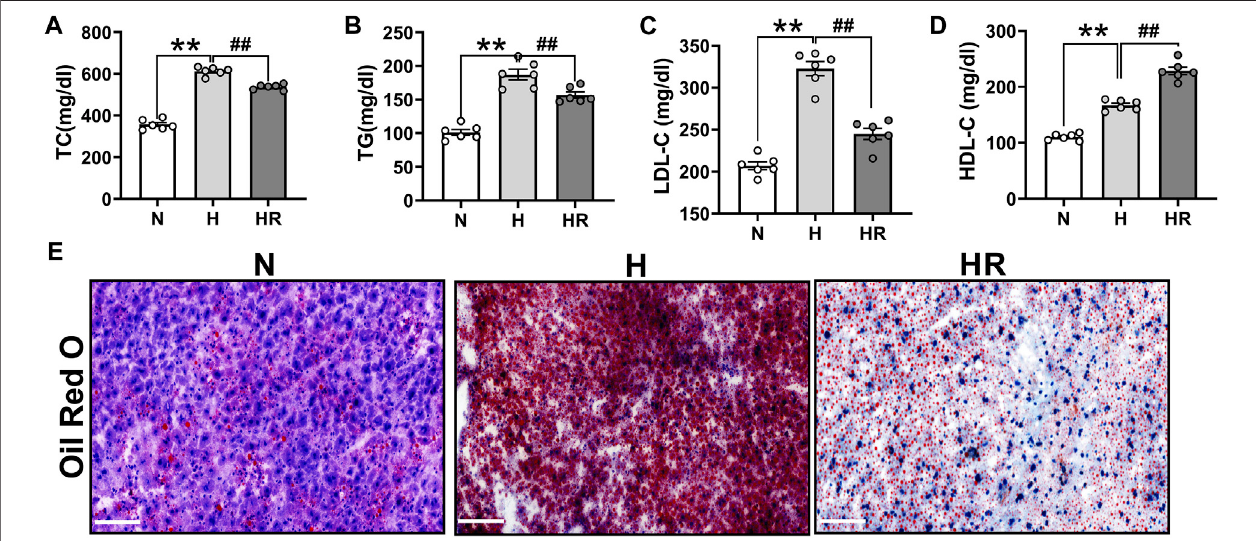
FIGURE 2 | Resveratrol regulated serum lipid and prevented the lipid accumulation in the liver of ApoE − / − mice. (A – C) Total cholesterol (TC) (A) , triglycerides (TG) (B) , and low-density lipoprotein cholesterol (LDL-C) (C) were dominantly inhibited by treatment with REV for 24 weeks in ApoE − / − fed with HFD. (D) REV could increase thelevelofhigh-densitylipoprotein(HDL)inApoE − / − fedwithHFD. (E) RepresentativeexamplesoflivertissuesstainedbyusingOilRedO. × 200,Scalebar. n (cid:2) 6micein each group. All data are mean ± SEM. ** p < 0.01 vs. N group; ## p < 0.01 vs. HR group. “ N ” denotes normal; “ H ” indicates high-fat diet; and “ HR ” denotes high-fat diet plus resveratrol (REV) treatment.